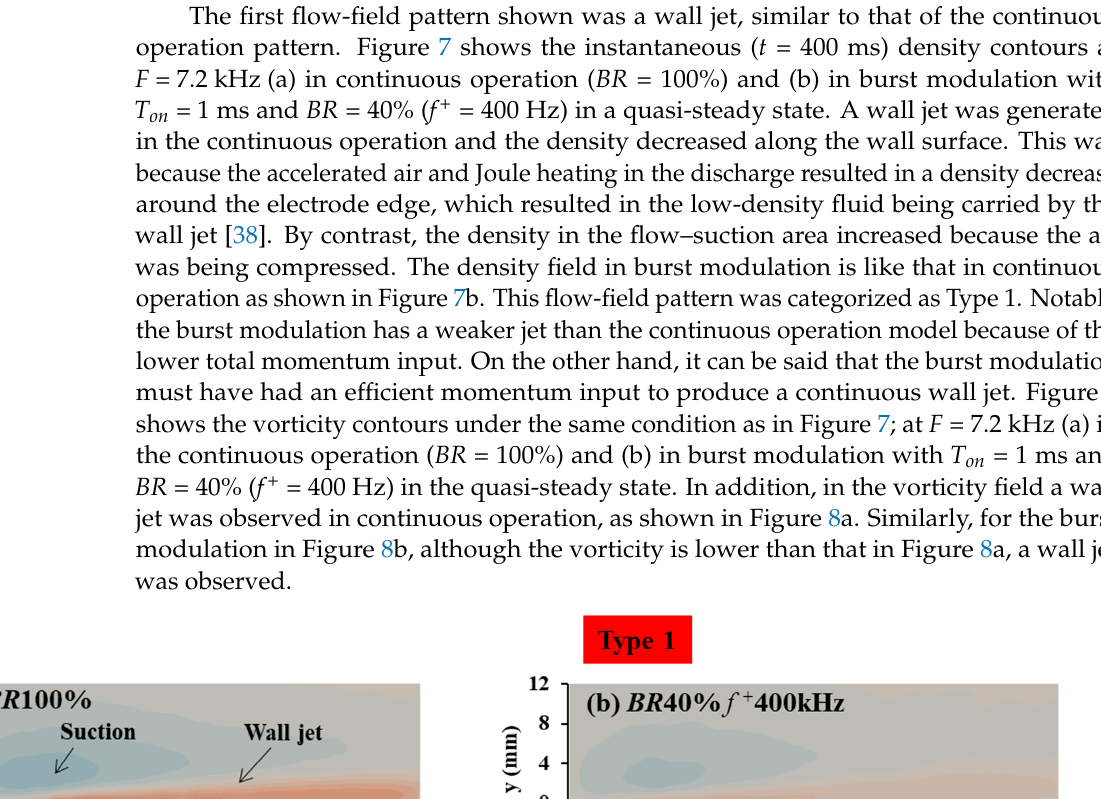
Figure 8. Vorticity-field contours for the case of ( a ) continuous operation with F = 7.2 kHz and BR = 100% and ( b ) burst modulation with F = 7.2 kHz, BR = 40% and T on = 1 ms ( f + = 400 Hz). The second flow-field pattern features periodical independent vortices moving on the wall surface without detaching from the wall surface. Figure 9 shows the time series of (a) density field contours and (b) vorticity contours at F = 7.2 kHz in burst modulation with BR = 40% and T on = 2 ms ( f + = 200 Hz) in the quasi-steady state. Figure 9a shows that the density contours at 2–25 ms exhibit independent vortex formation. At 25 ms, the vor- tex travels while in contact with the surface and gradually dissipates in travel. In contrast, Figure 9b vorticity contours at 2–25 ms show difficulty in determining independent vor- tices and a distribution similar to that in Figure 8 for the wall jet. The dotted arrows in Figure 9 indicate the direction of vortex advection. Initially, the air is accelerated by the body force due to plasma, then the wall jet appears as shown in Figure 9a,b at 2 ms. The vortex increases while moving on the surface in Figure 9a,b at 5 ms. Thereafter, the vortex does not detach from the wall surface but continues to move in a shape of lateral ellipse on the wall surface at 10–15 ms, as shown in Figure 9a. However, Figure 9b vorticity con- tours (after 10–25 ms) do not identify the location of the vortex. The fluid in the density field was Joule heated and simultaneously accelerated by body force. Burst modulation periodically heats the fluid and because the periodically heated fluid expands during ad- vection it forms a periodic structure. However, the velocity field is considered less likely to have a periodic structure owing to the effects of inertia. As shown in Figure 9a, at 25 ms the vortex gradually dissipates as it moves along the wall’s surface. This flow pattern is categorized as Type 2. The width of the Type 2 wall jet is also similar for both the density and vorticity fields.